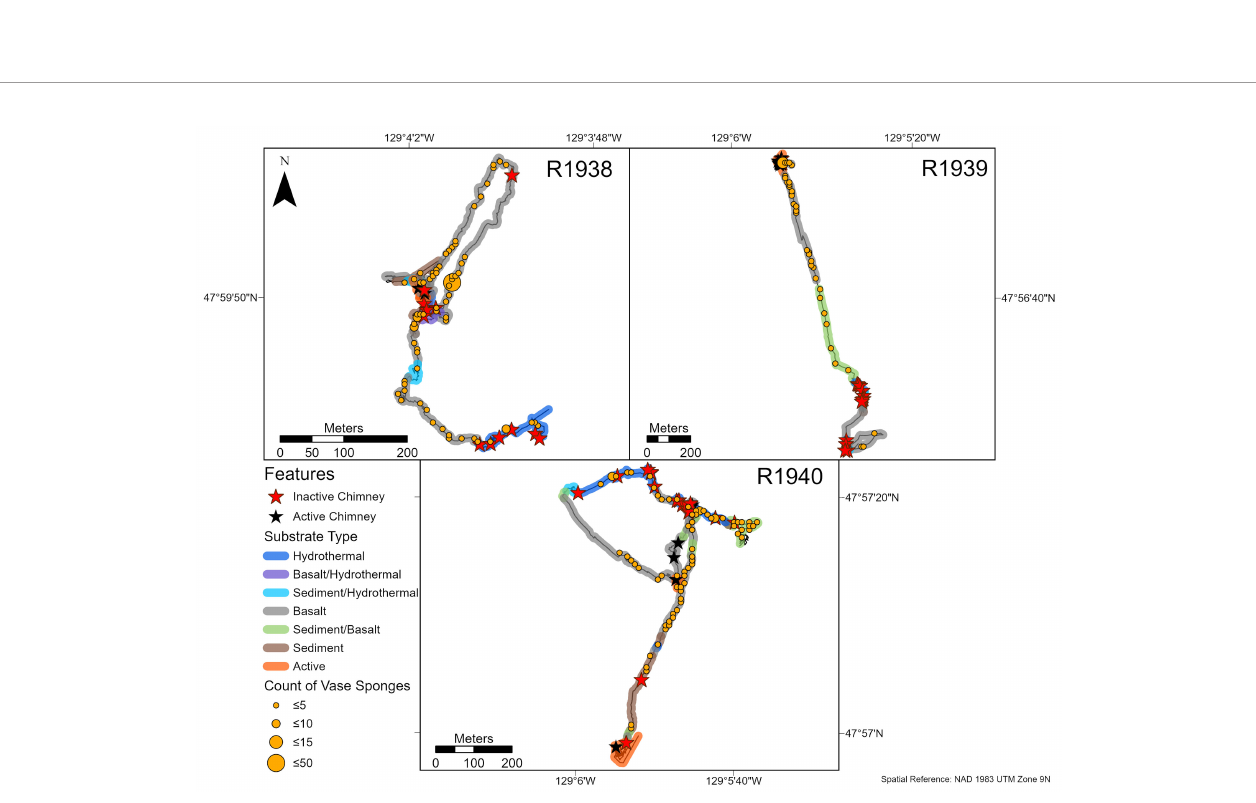
FIGURE 6 | Abundance and distribution of rossellid vase sponges (Rossellidae) on dives R1938-R1940 at the Endeavour segment, Juan de Fuca Ridge in August 2016. Inactive and active chimney locations and broad scale substrate classi fi cations are also plotted onto the track. “ Hydrothermal ” substrate refers to inactive substrate that is hydrothermally derived. Counts were summed over a 10 x 10 m tessellation in ArcGIS